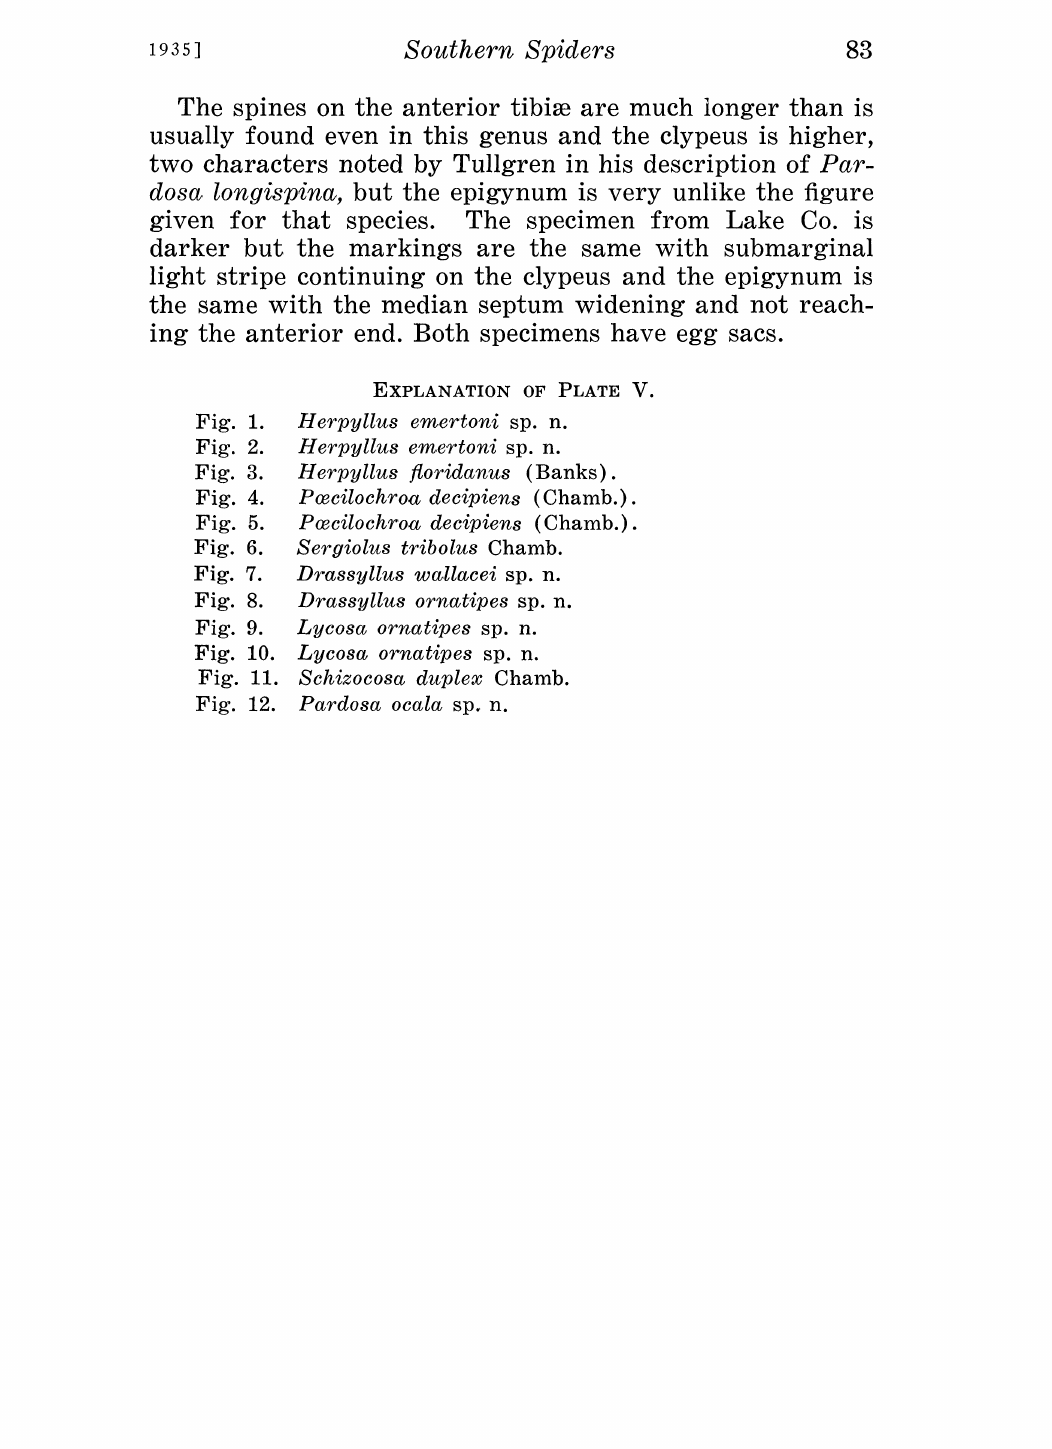
EXPLANATION OF PLATE